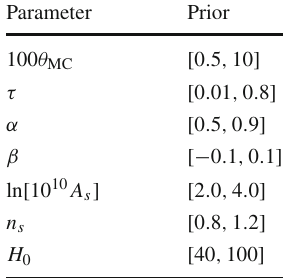
Fig. 3 The upper left and lower left panels corresponding to a plus sign in Eq. (29) represent the relation between the phantom field φ and the scale factor a , and the relation between the phantom field φ and the potential V 2 / V 0 . The upper right and lower right panels corresponding to a minus sign in Eq. (29) represent the relation between the phantom